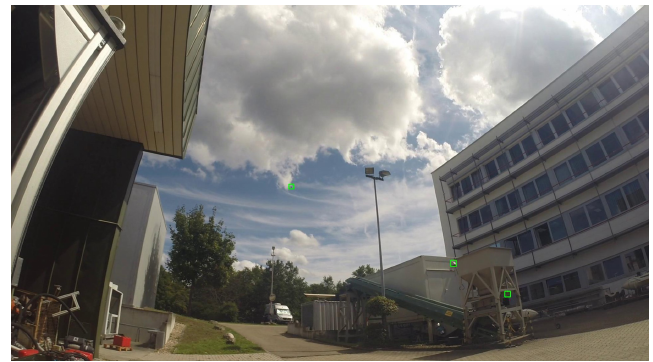
Figure 15. Model classifying random objects.